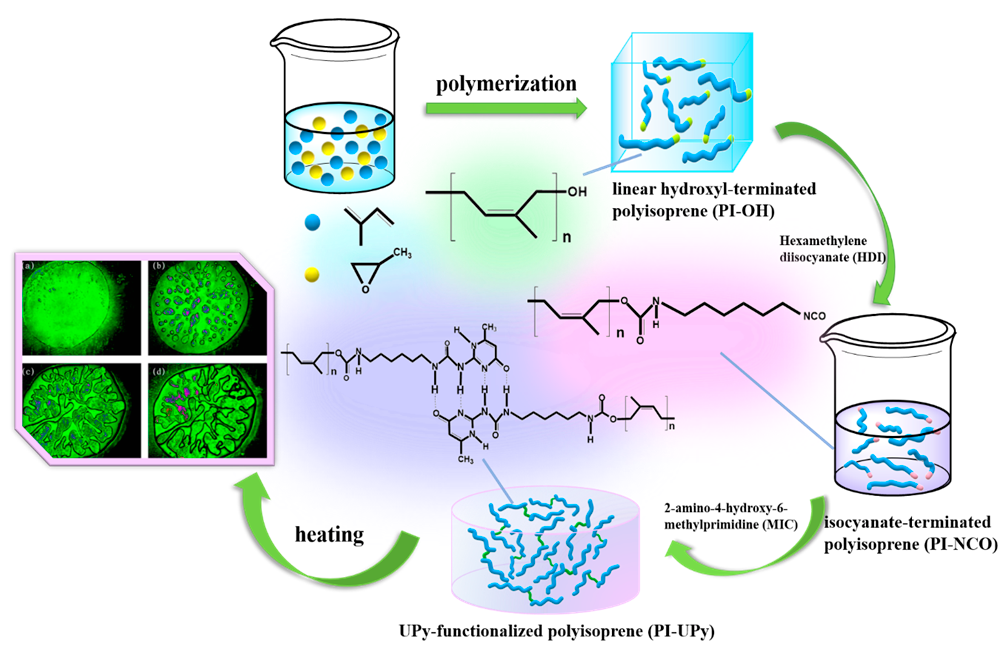
Figure 1. Synthetic process of 2-ureido-4 [1 H ]-pyrimidinone (UPy)-functionalized linear polyisoprene supramolecular elastomer (LSPE) and its heating photos by polarizing microscope